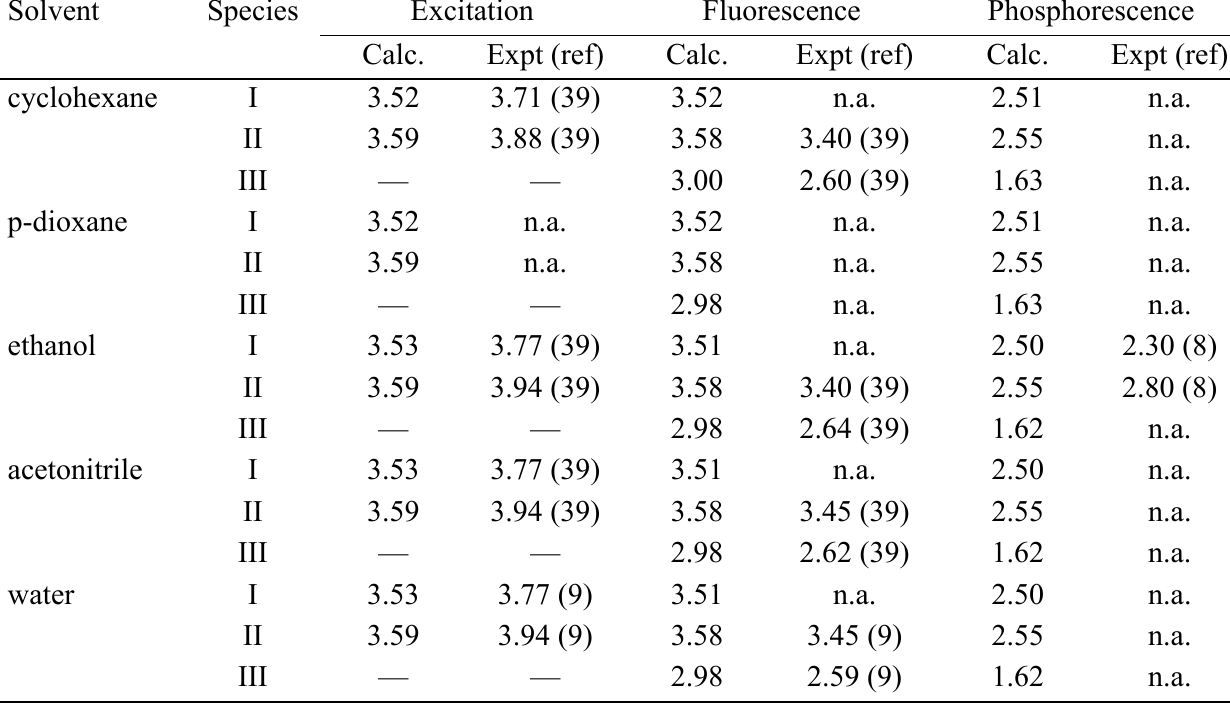
Table 9. Assignment of excitation, fluorescence and phosphorescence spectra of HBO in different solvents in terms of calculated energies (eV). Numbers within parentheses refer to the references corresponding to the experimental data. (n.a. indicates non-availability of data).